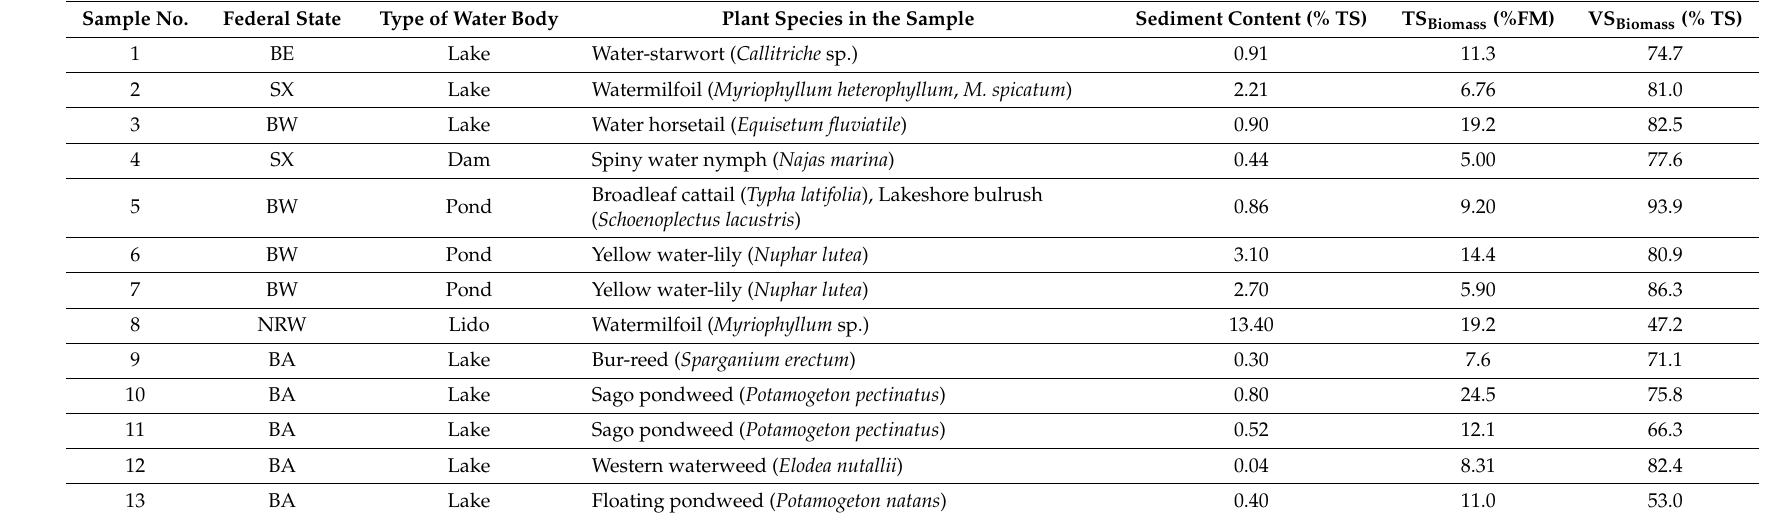
Table 1. Properties of plant material in samples from standing bodies of water (samples 8–13 are from summer harvesting). Sample